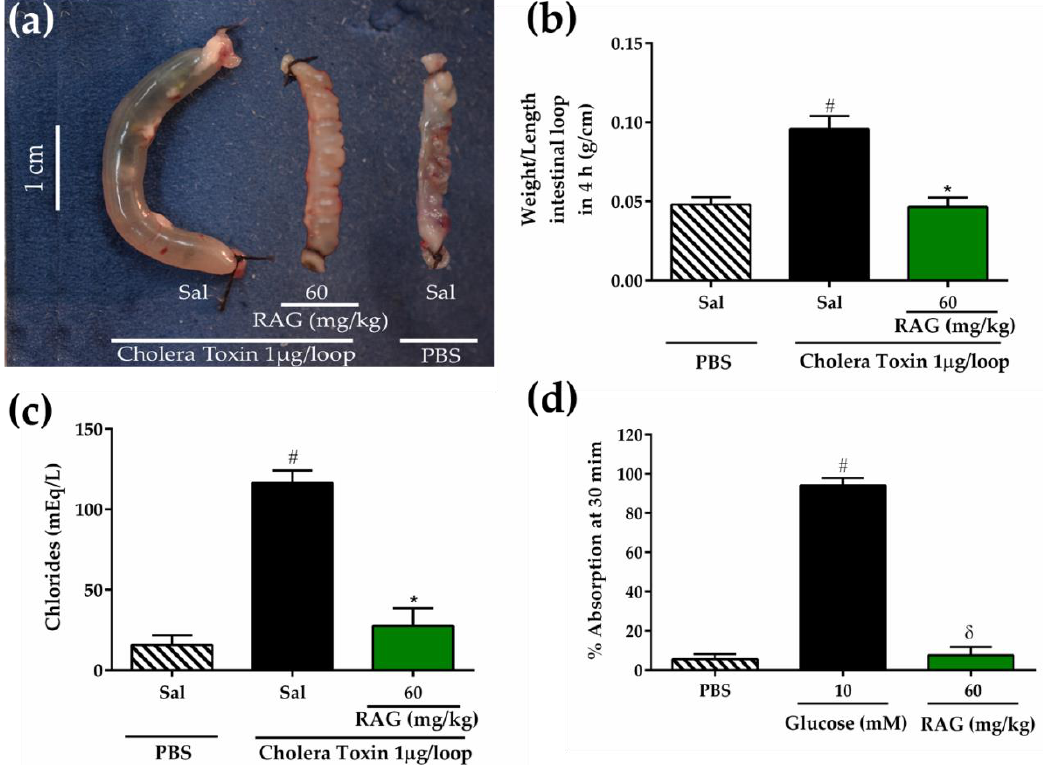
Figure 6. Inhibitory effects of RAG on CT-induced fluid secretion in the intestinal loops. ( a ) Intestinal fluid secretion accumulation was measured at 4 h after inoculation of CT (1 μg/loop) into an intestinal loop. ( b ) Fluid secretion was measured indirectly by the ratio of the loop weight/length. ( c ) The levels of Cl- were measured in the intestinal contents of isolated loops inoculated with CT. ( d ) Intestinal fluid absorption was measured in isolated loops 30 min after injection with RAG (60 mg/kg), PBS, or glucose (10 mM). The fluid absorption was calculated by the difference between full and empty loops and measured as the weight/length ratio. A minimum of five animals were used per group. The results are expressed as the mean ± S.E.M. *P < 0.05 vs. the CT group; #P < 0.001 vs. the PBS group; δ P < 0.05 vs. the glucose group. Statistics: one-way ANOVA with Tukey post-hoc test. Abbreviations: RAG = red angico gum; CT = Cholera Toxin.